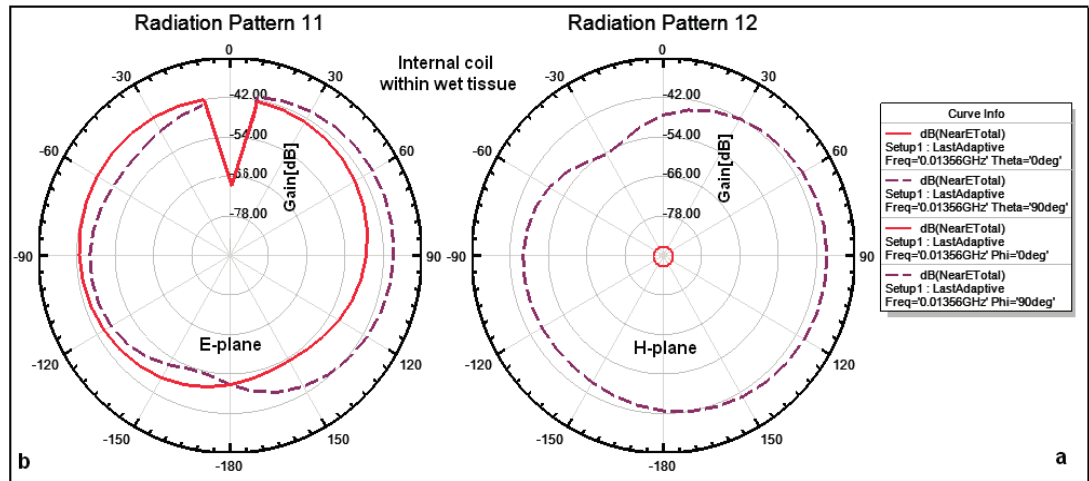
Figure 10. Simulated patterns for total near field surrounding an internal coil within tissue: ( a ) on the azimuthal plane ( θ = 0°, θ = 90°); ( b ) on the elevation plane ( Φ = 0°, Φ = 90°),